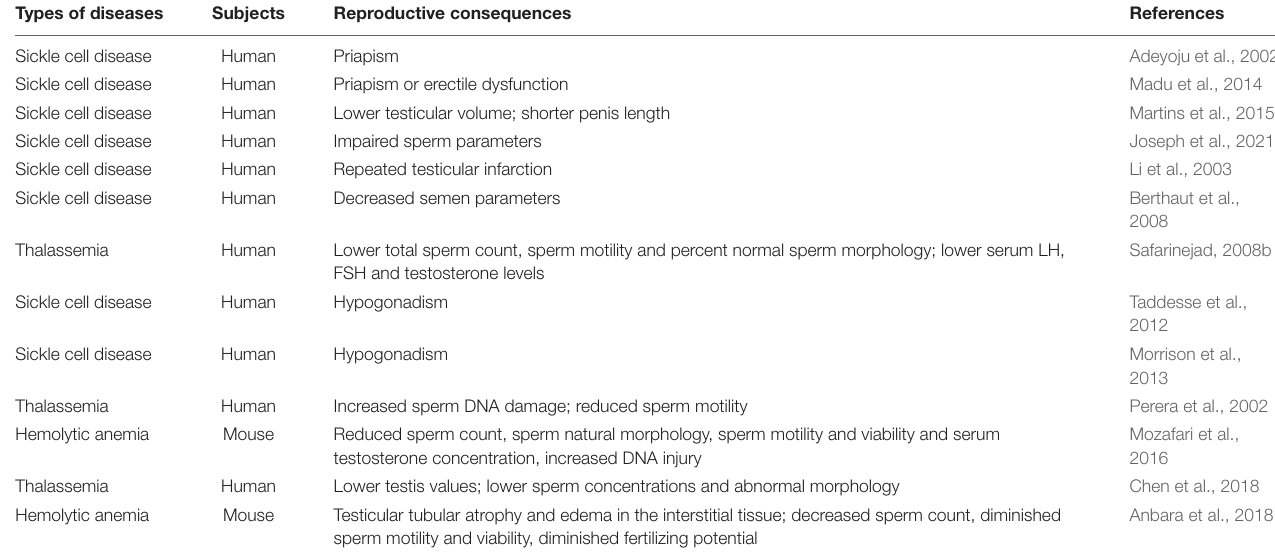
TABLE 5 | Summary of the studies reporting the reproductive consequences of hematological